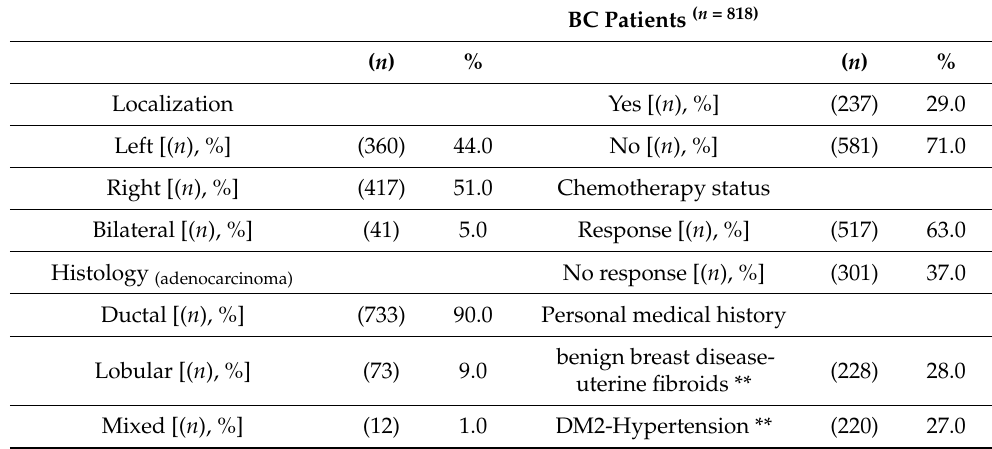
* According to OMS classifications (appropriate body mass index for Asian populations and its implications for policy and intervention strategies. (Geneva, Switzerland): World Health Organization (WHO), 2004). ** On base n = 818. The rs4880 variant in the SOD2 gene was significantly different between BC patients and controls. The genotypes CT [odds ratio (OR) 1.5, 95% confidence intervals (CI) 1.11–2.08, p = 0.009], TT (OR 2.0, 95% CI 1.12–3.58, p = 0.023), CTTT (dominant model; OR 1.91, 95% CI